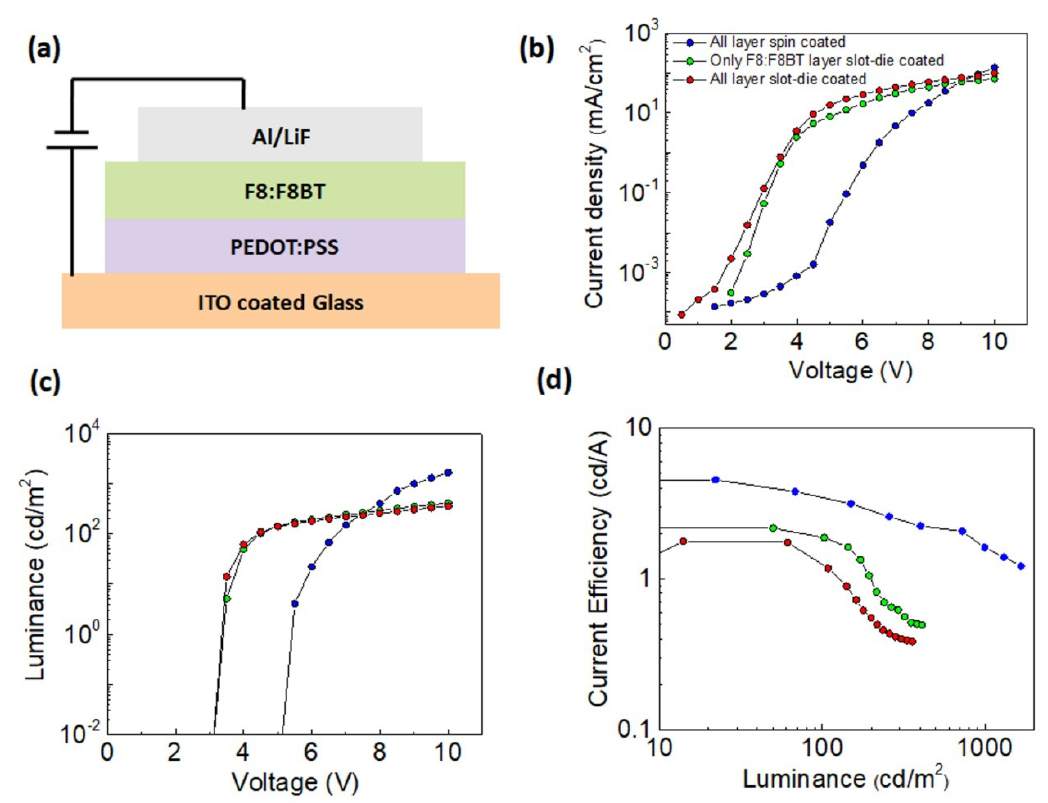
Figure 11. ( a ) Schematic of the OLED structure. Comparison of performances of OLEDs in which both PEDOT:PSS and F8:F8BT layers were spin-coated, both layers were slot-die coated and only F8:F8BT layers were slot-die coated: ( b ) current density vs. voltage, ( c ) luminance vs. voltage, and ( d ) current efficiency vs. luminance.